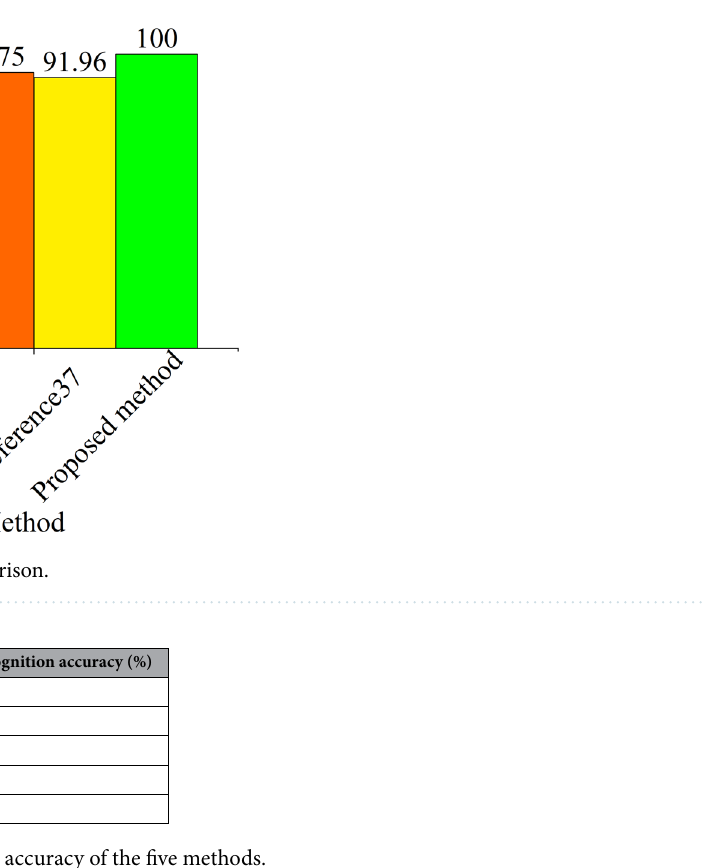
Table 2. Comparison of the accuracy of the five